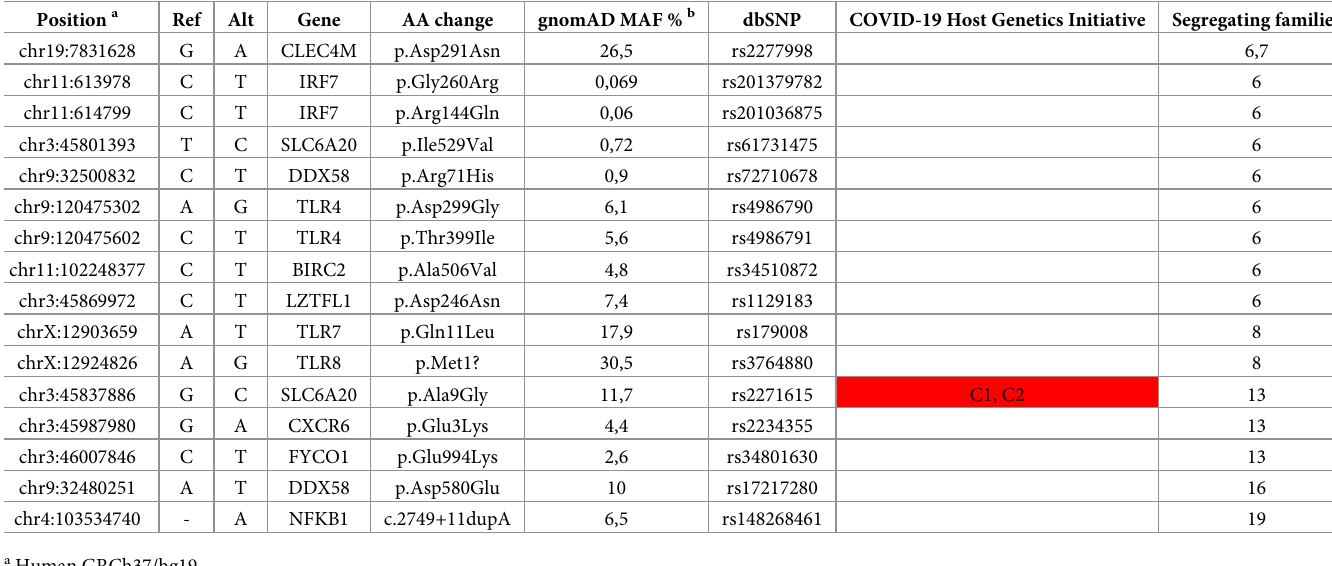
Table 4. Familial segregation of variants in families with severe COVID-19.